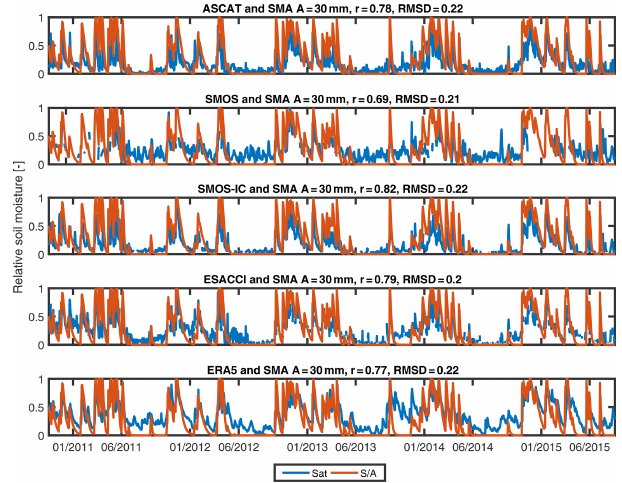
Figure 5. Relationship between the different products of soil mois- ture and SMA model outputs between 18 October 2010 and 20 Au- gust 2015 in the Issyl basin.